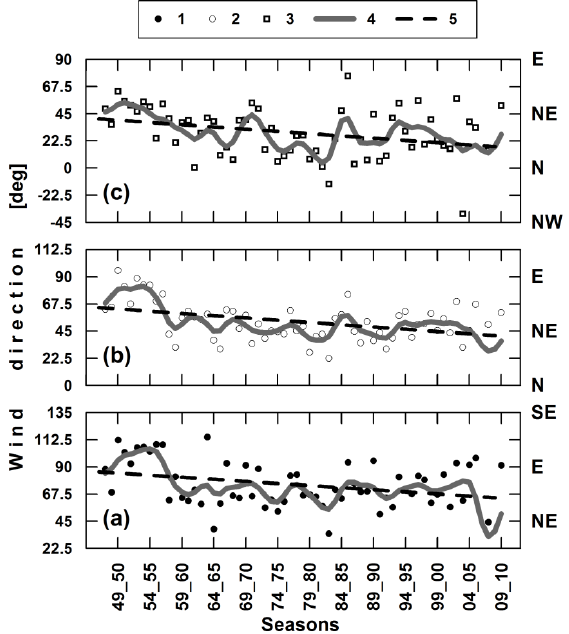
Figure 10. Variability of average wind direction for each of the storm phases during 1948-2010. Downward trend indicates northward shift of prevailing wind direction; (a) growth phase: 1 – data points, 4 – LPF approximation, 5 – global linear trend (3.5 degdecade − 1 , R 2 = 0 . 103), (b) developed sea phase: 2 – data points, 4 – LPF approximation, 5 – global linear trend (3.75 degdecade − 1 , R 2 = 0 . 17), (c) decay phase: 3 – data points, 4 – LPF approximation, 5 – global linear trend (3.71degdecade − 1 , R 2 = 0 . 096).